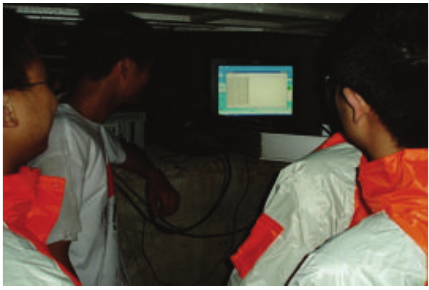
Figure 7: Adjusting the measurement